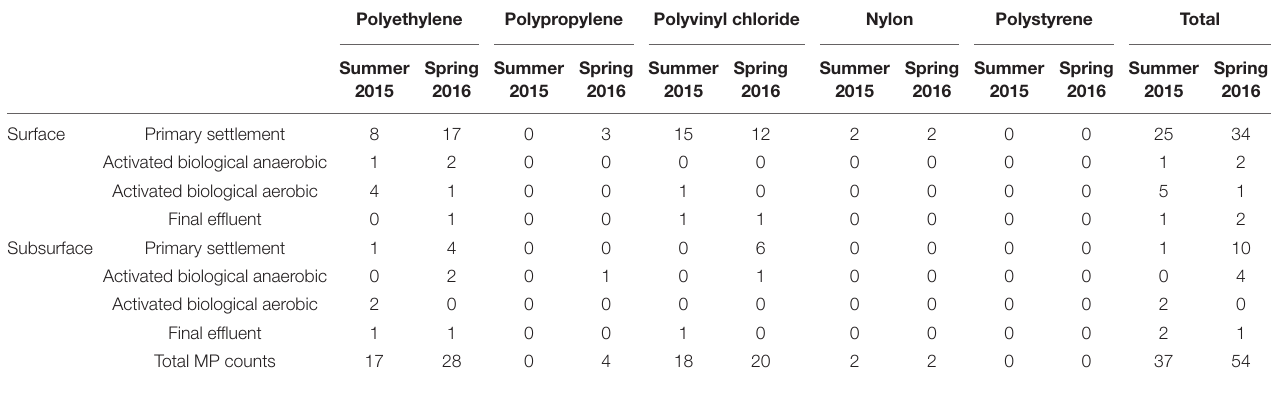
TABLE 1 | Microplastic count data and polymer type across the four wastewater stages, in both surface and subsurface samples. Samples were collected from both the surface (top 5 cm) and subsurface (depth of 2.5 m, except for the final effluent where the sampling depth was ∼ 60